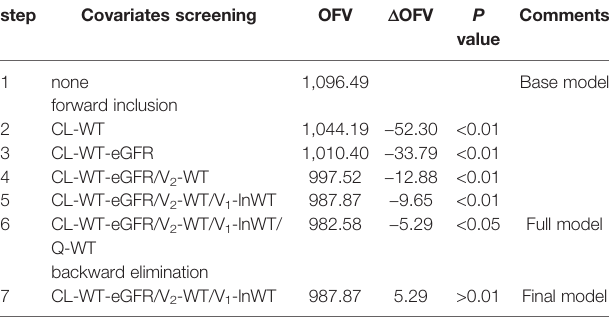
Table 4 showed the parameters and bootstrap con fi dence